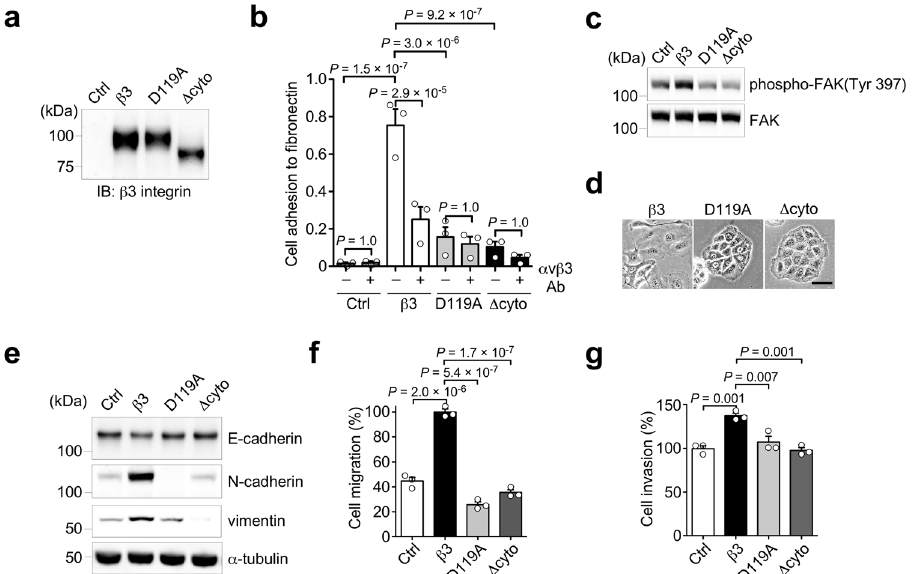
Fig. 5 α v β 3 integrin signaling is required for its inducible partial EMT. a Western blotting of β 3 integrin in control, β 3, D119A β 3, and Δ cyto β 3 integrin- expressing A549 cells. b Cell adhesion of control, β 3, D119A β 3, and Δ cyto β 3 integrin-expressing A549 cells to fi bronectin, and the inhibitory effect of α v β 3 integrin antibody on the cell adhesion. c Phosphorylation of FAK in control, β 3, D119A β 3, and Δ cyto β 3-expressing A549 cells. d Cell morphology of β 3, D119A β 3, and Δ cyto β 3 integrin-expressing A549 cells. Scale bar, 50 µ m. e Western blotting of EMT markers in control, β 3, D119A β 3, and Δ cyto β 3 integrin-expressing A549 cells. f , g Cell migration ( f ) and invasion ( g ) of the indicated A549 cells. One-way ANOVA and Bonferroni post-hoc test, mean ± s.e.m. of three independent assays conducted in triplicate. The source data are provided in Supplementary Data 1. Unprocessed blot images in ( a , c and e ) are shown in Supplementary Fig. 6.